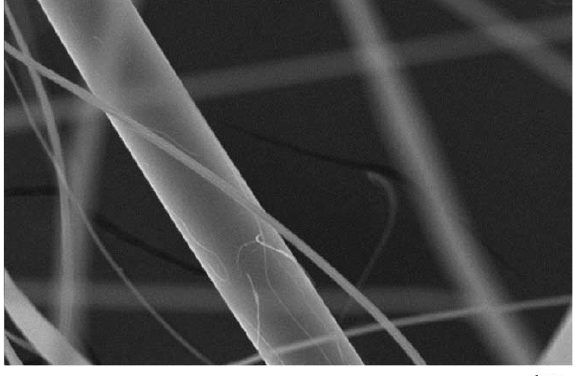
Figure 5. SEM picture of electrospun EPS nanofiber and commercial glass fiber (Adapted from